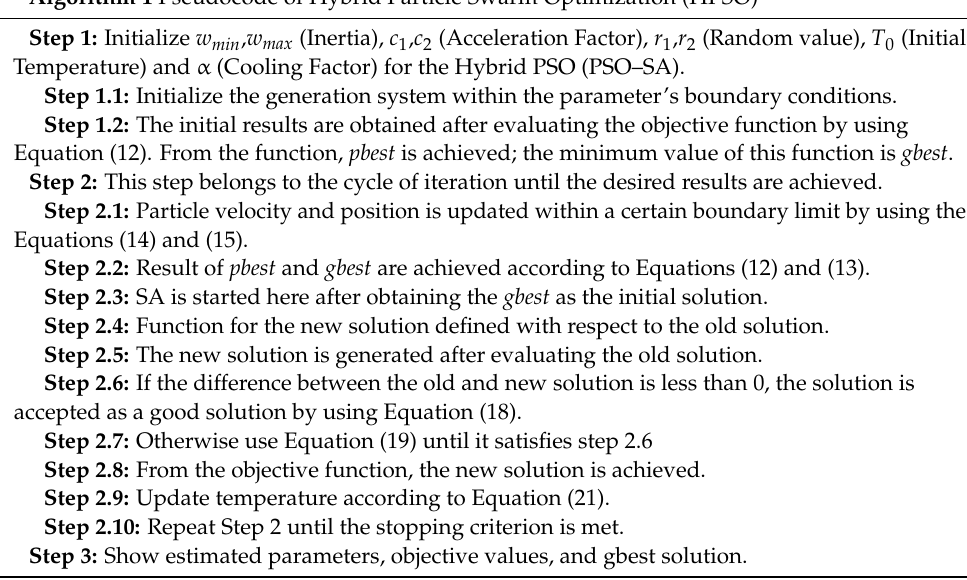
Pseudocode of HPSO